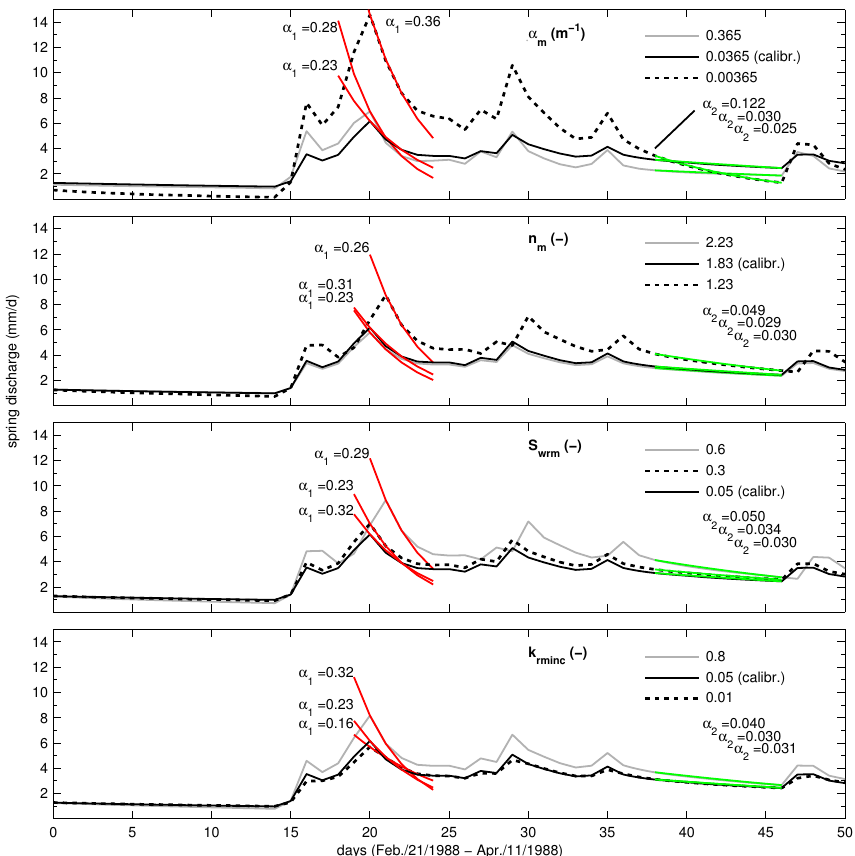
Fig. 9. Variation of the van Genuchten parameters ( α m , n m , S wrm , k rminc ).